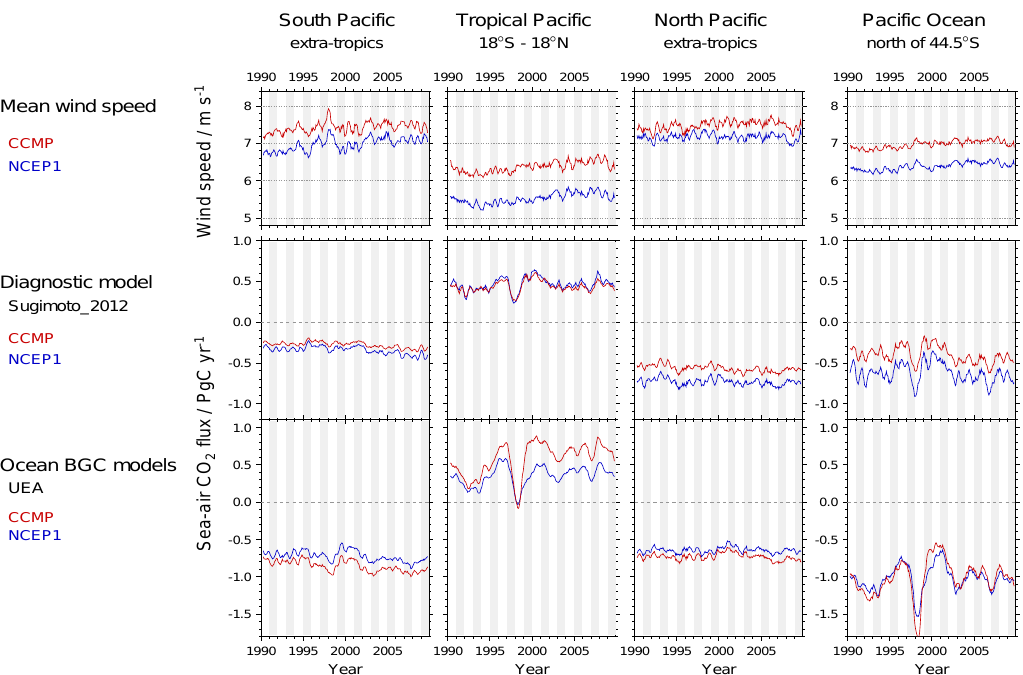
Fig. 10. Trend (5-month running means) of the Southern Oscillation Index (SOI) (http://ds.data.jma.go.jp/tcc/tcc/products/elnino/index/), and the air–sea CO 2 flux anomalies over the Pacific (44.5 ◦ S–66 ◦ N; black), in the tropical Pacific (18 ◦ S–18 ◦ N; red), in the North Pacific extratropics (18 ◦ N–18 ◦ S; blue), and in the South Pacific extratropics